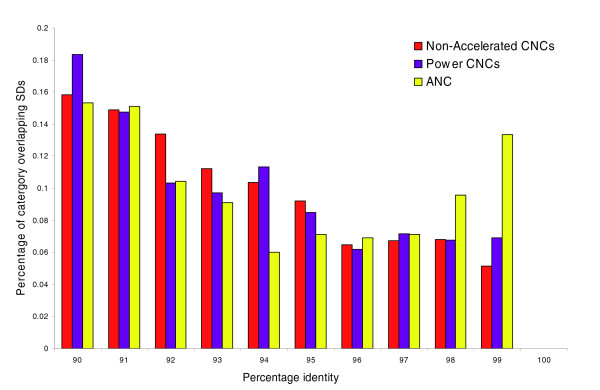
Segmental duplication divergence in ANC and CNC sequences. The figure shows that the divergence of paralogs in segmental duplications (SDs) where conserved noncoding (CNC) sequences (red) and power CNC sequences (purple) are found is skewed to high divergence values, whereas the accelerated noncoding (ANC) sequences (yellow) have a strong enrichment in recent segmental duplications, as expected if the acceleration is due to a recent change in selective forces (positive selection or loss of selective constraint).